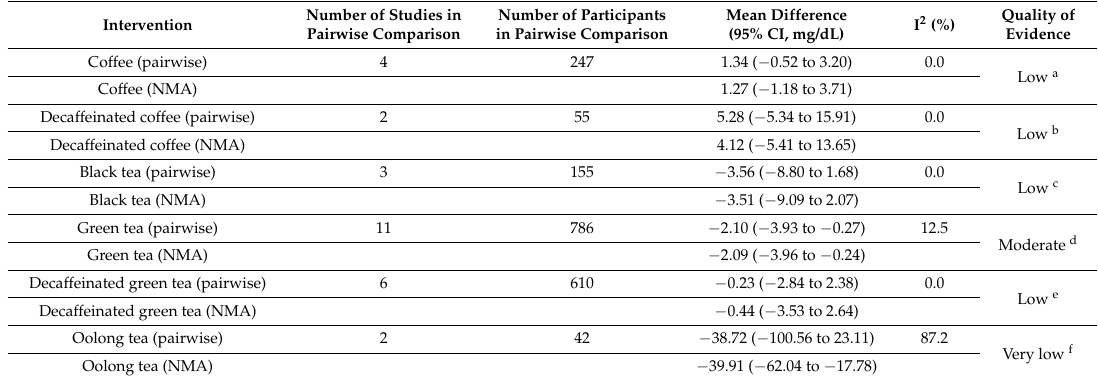
Table 2. Intervention effect on fasting blood glucose vs. placebo/water.